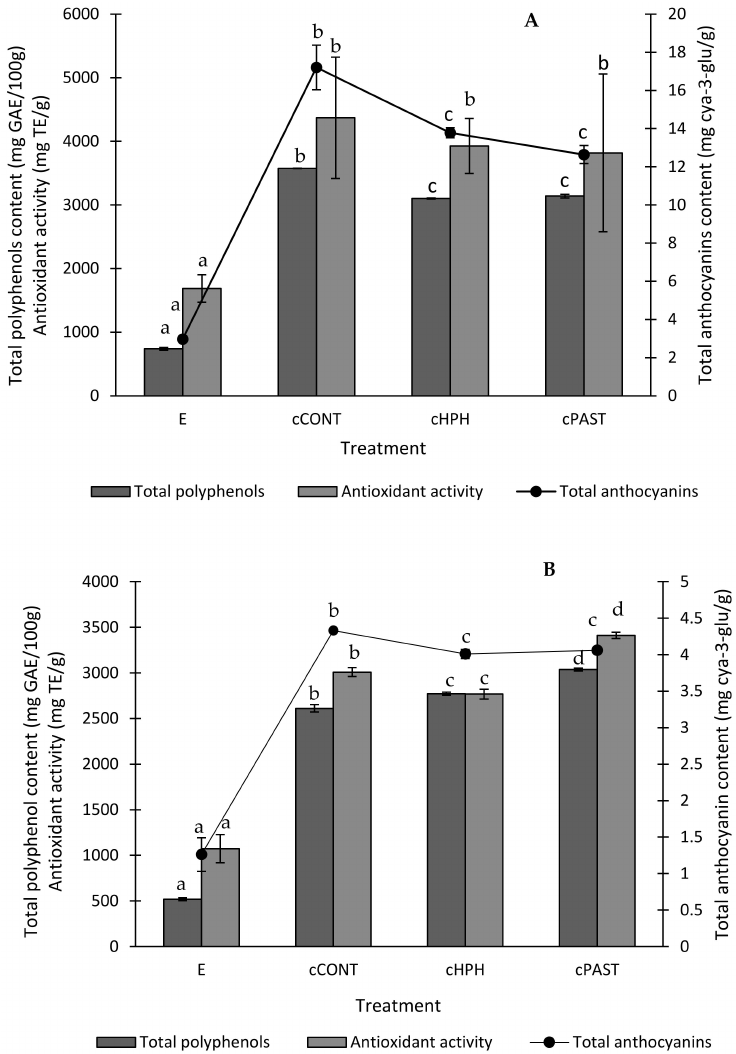
Figure 3. Contents of bioactive compounds (total polyphenols, total anthocyanins, and antioxidant capacity) in maqui ( A ) and calafate ( B ) extracts and cryoconcentrates. E, extract; cCONT, cryoconcentrate control; cHPH cryoconcentrate previously treated by high–pressure homogenization; cPAST, cryoconcentrate previously treated by pasteurization. Different letters (a–d) for the same variable indicate significant differences between the means of the different treatments ( p ≤